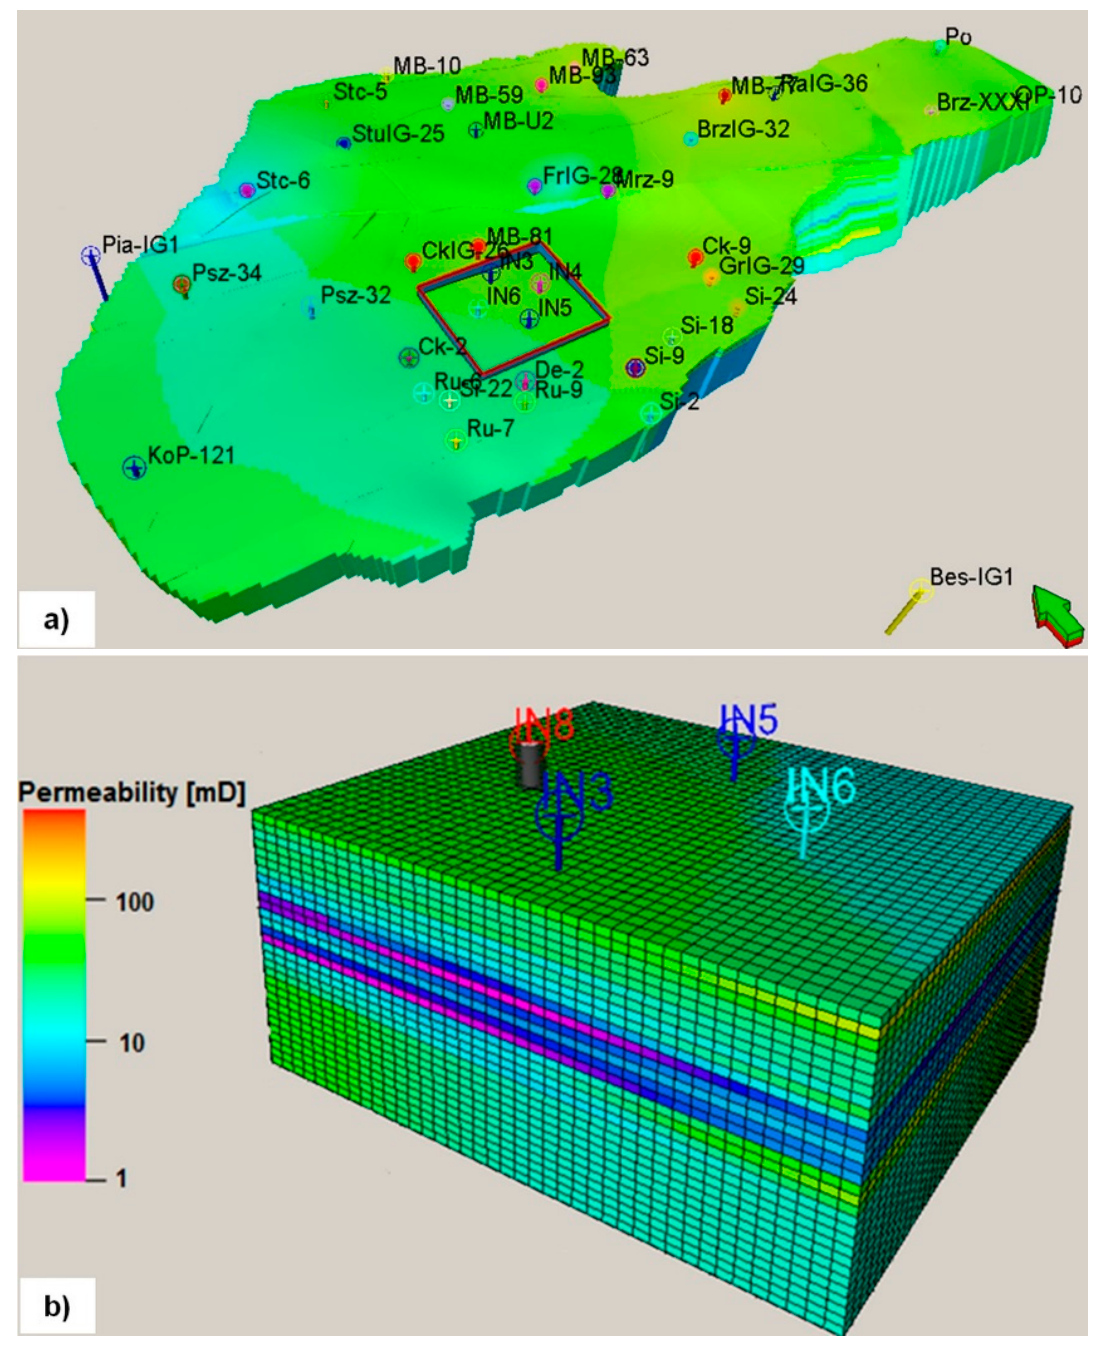
Figure 2. Static model within the Cracow Sandstone Series ( a ) with a separate local model, a permeability distribution model ( b ), for the purpose of reservoir simulations.